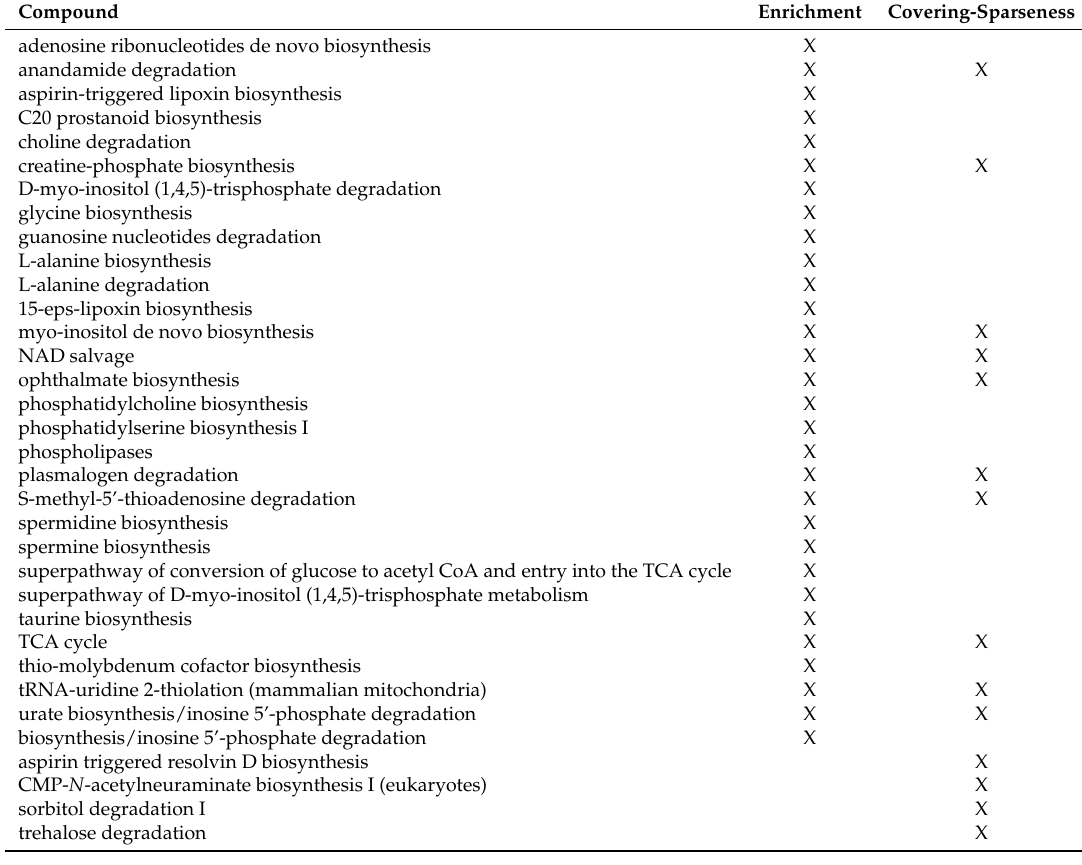
Table 7. Comparison of ST000741 Pathway Enrichment to Pathway Covering using Covered Compound